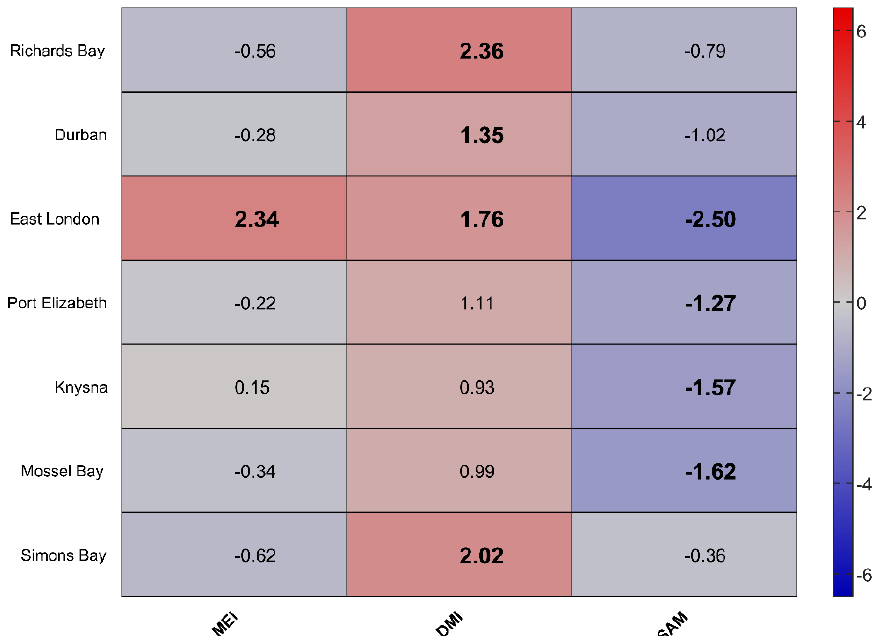
Figure 10. Sea level composite mean difference (cm) based on MEI (ENSO), DMI (IOD) and SAM indices at all studied tide gauges. The tide gauges are labelled with their names ( y -axis), from east to south. Colour indicates the magnitude of SL differences during positive and negative indices. Numbers in bold are based on composite means that are significantly different above the 95% level, according to two sampled t -tests.